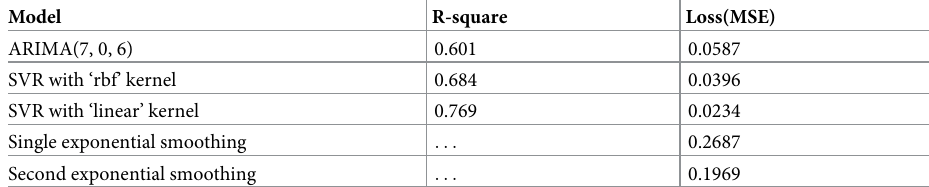
Table 6. Summary of ARIMA, SVR and simple statistical model fitting.